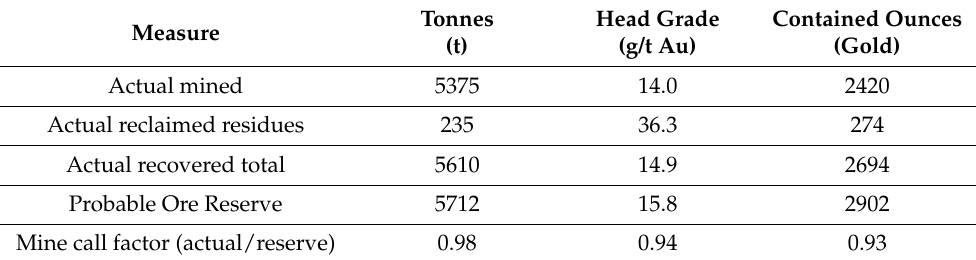
Table 12. Reconciliation between the 200 drive actual extracted (mined and residue) and the original model. All grades back-calculated to head grade. Actual mined based on reconciliation of gold produced from plant and tailings samples. Actual reclaimed residues based on reconciliation of gold produced from pilot plant and tailings samples. Ore reserve head grade based on grade control drilling. Figures may not compute due to